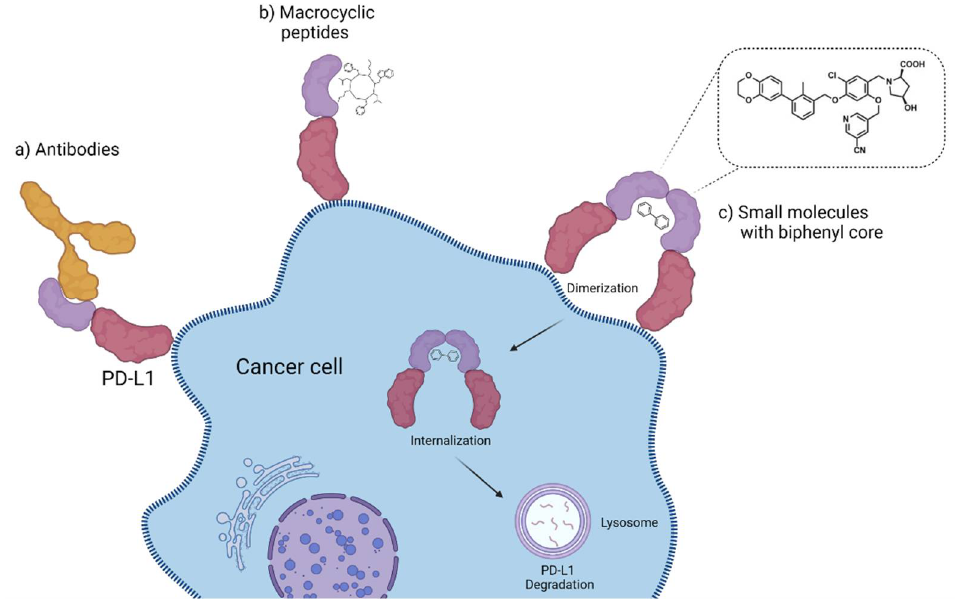
Figure 16. Binding modes of PD-L1-targeting antibodies, peptides, and biphenyl-based small molecule inhibitors [129]. The latter ones show internalization and lysosome-dependent degradation of PD-L1 [132].